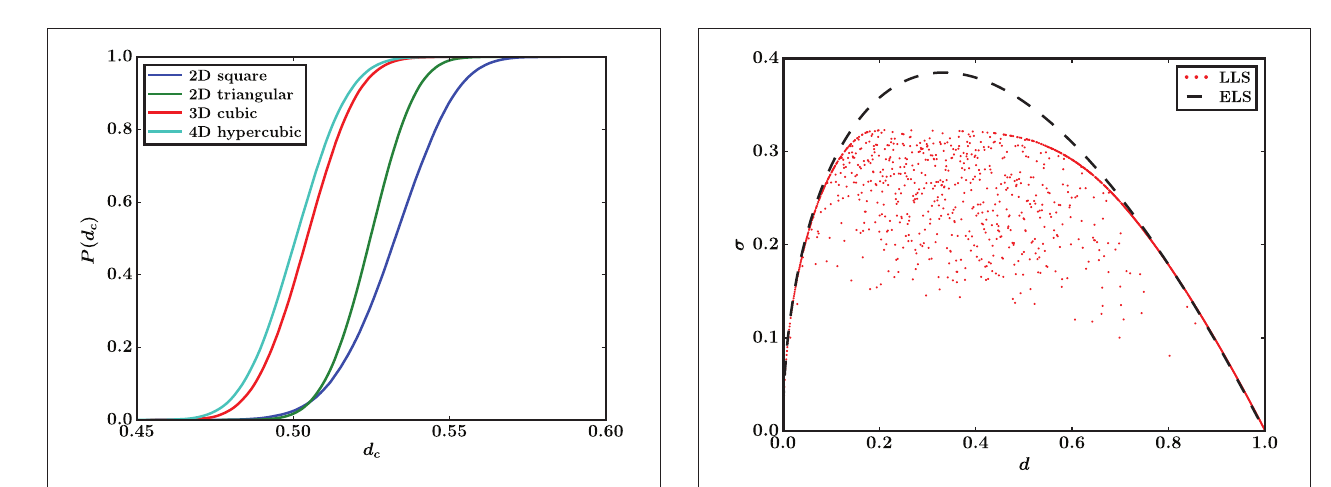
FIGURE 7 | Cumulative distribution of critical damage P ( d c ) for LLS on four lattices with similar number of fibers: square ( N = 128 2 ), triangular ( N = 128 2 ), cubic ( N = 25 3 ), and 4D hypercubic ( N = 11 4 ), all simulated with 10 5 samples. The threshold distribution is uniform: P ( t ) = t .